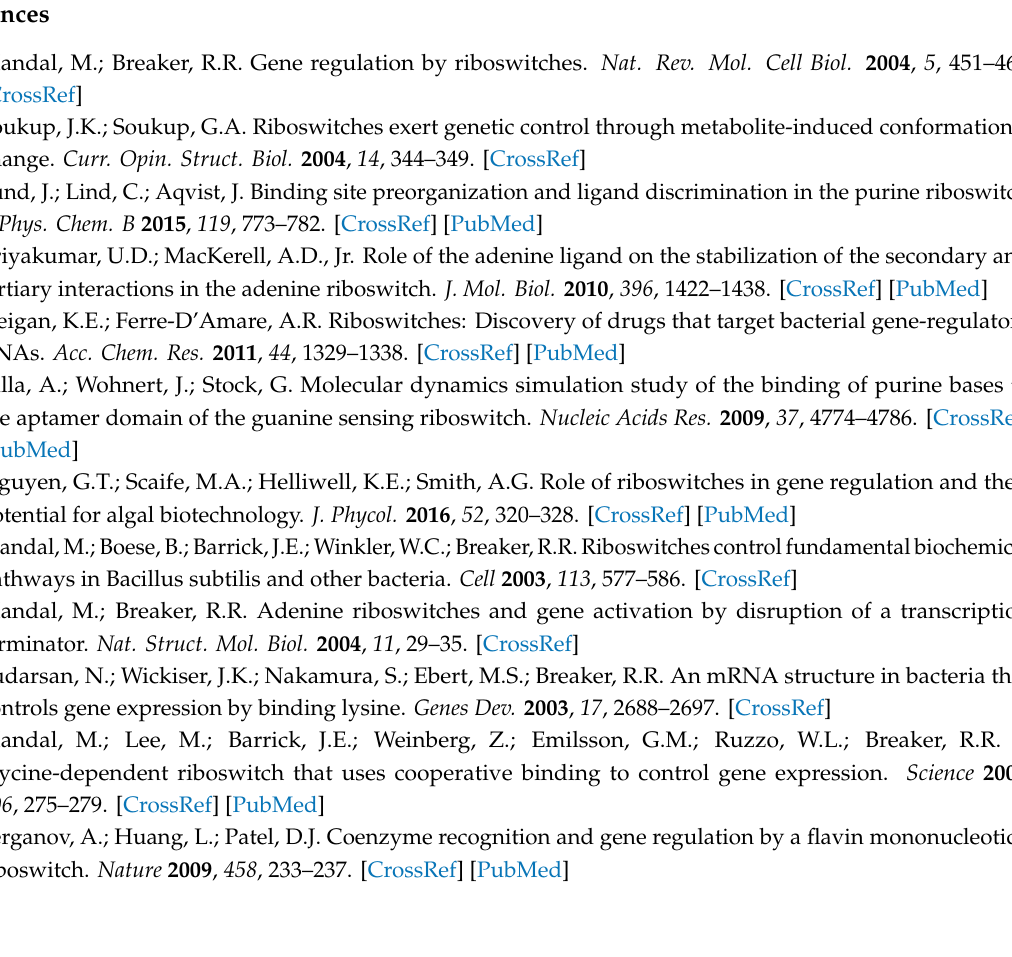
s1. Figure S1: The decomposition of inhibitors on a per-nucleotide basis. Figure S2: The same as in Figure 3 except for the RNA is the AR. Figure S3: The same as in Figure 4 except for the RNA is the AR. Figure S4: (A) The RMSDs of apo and comp calculated on P, O3’, O5’, C3’, C4’, and C5’ atoms of the nucleotides of AR relative to their starting structures. (B) RMSFs for the P, O3’, O5’, C3’, C4’, and C5’ atoms of the nucleotides. The experimental RMSFs from the B-factor are also given. Figure S5: The key distances describe in Figure 6 versus the MD simulation time for conformational state change at the starting of the MD simulation